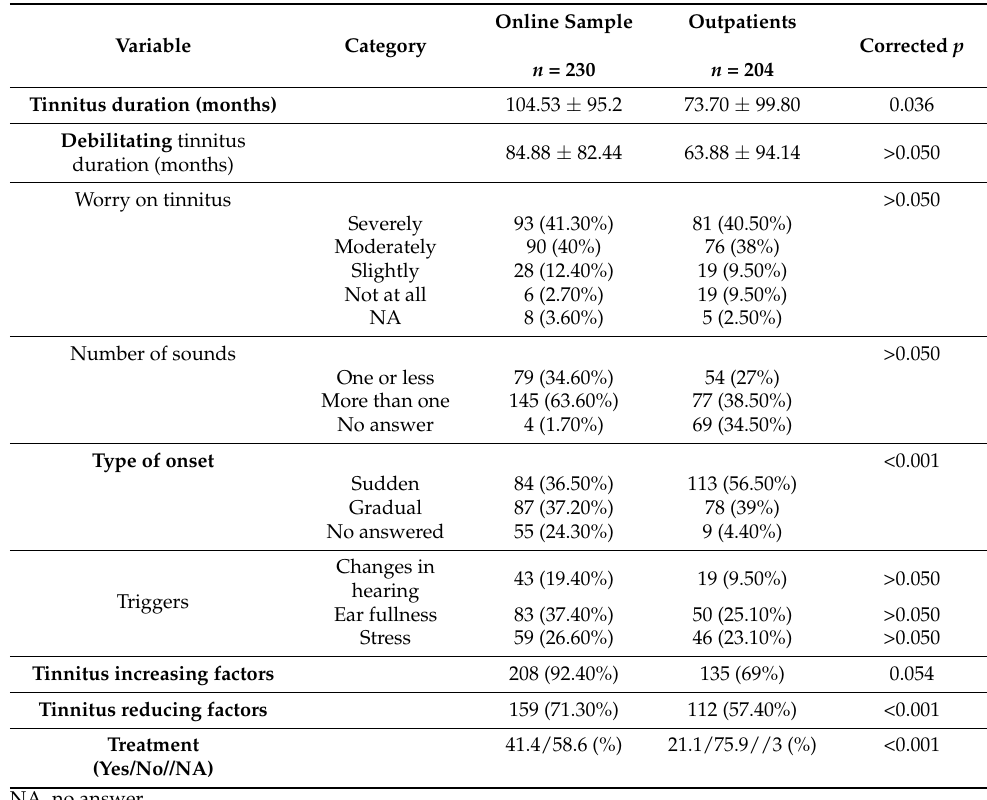
Table 2. Tinnitus characteristics in patients with chronic tinnitus ( n =